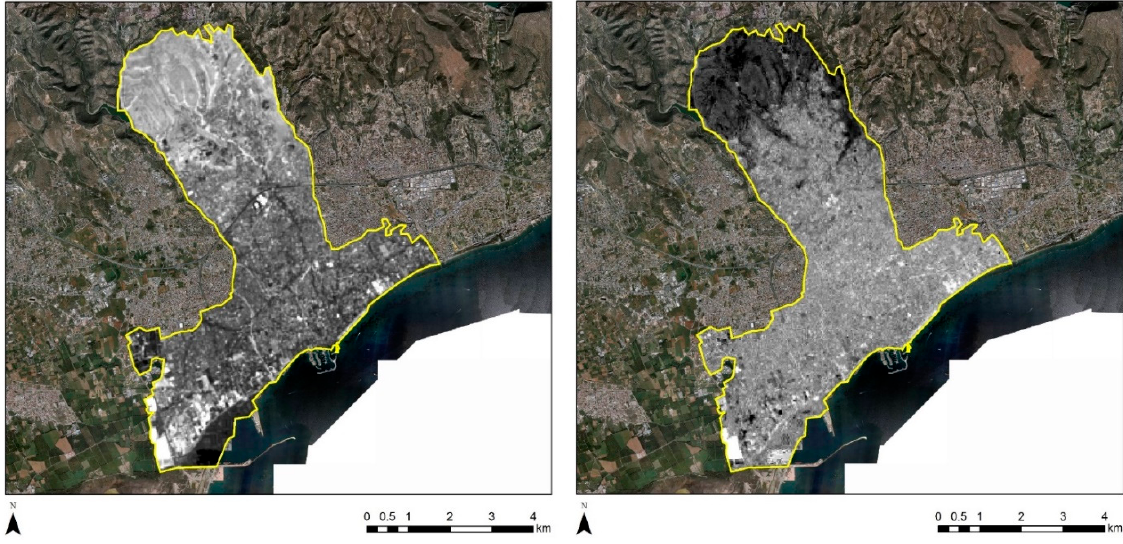
Figure 11. PCA analysis for the NDVI ( left ) and the NDBI ( right ) over the Limassol case study.